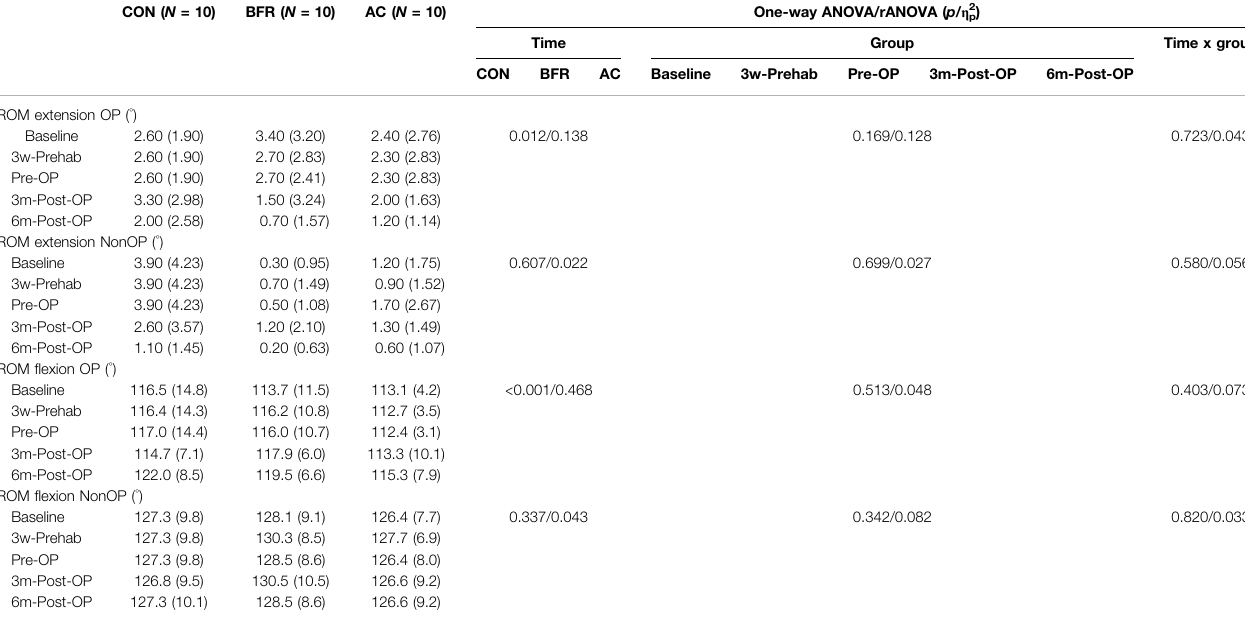
TABLE 5 | Active range of motion of knee joint during the prehabilitation- and post-operative period.